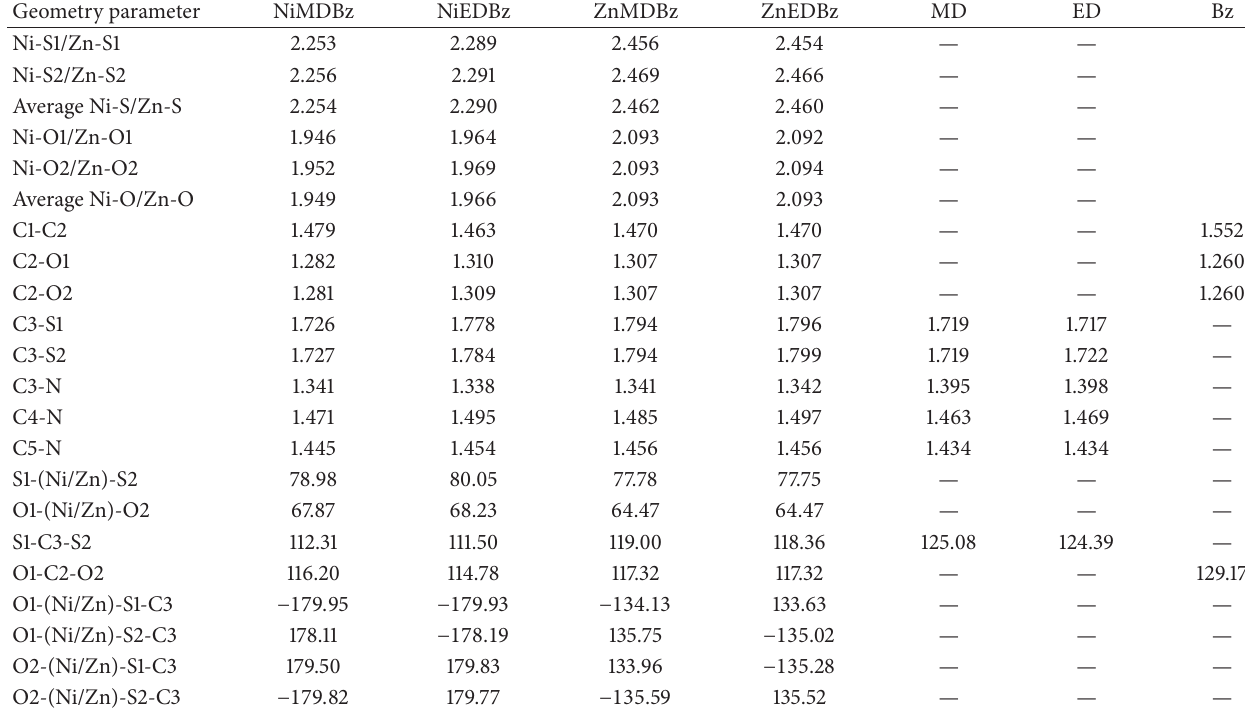
Table 1: Selected geometry parameters: bond lengths (˚A), bond angles ( ∘ ), and dihedral angles ( ∘ ) of the optimized geometries a . Geometry parameter Ni-S2/Zn-S2 Average Ni-S/Zn-S